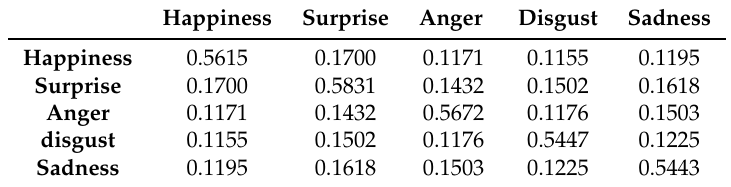
Table 6. Cosine similarity for the 3-CL CNN with double-channel inputs (Vx-Vy). Happiness Surprise